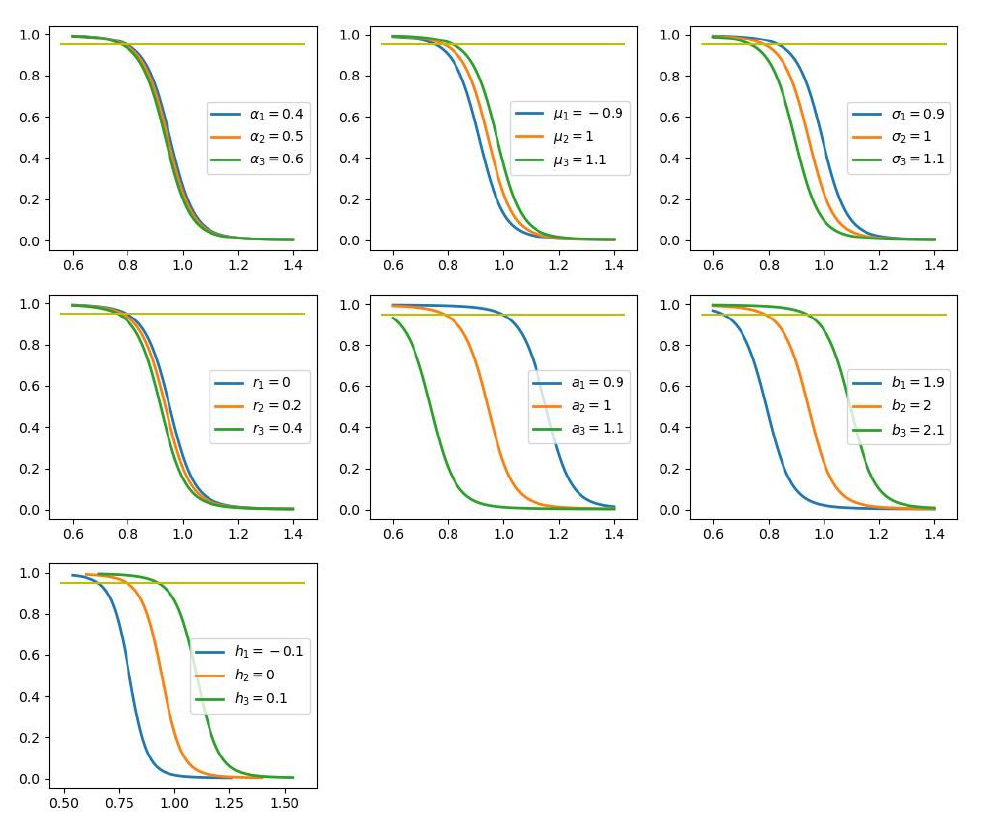
Figure 6. The figures show the graph of u 1 ( x ) for three different values of each parameter indicated in the figures for the CIR model. The horizontal line cuts the probability of stop at a confidence level of